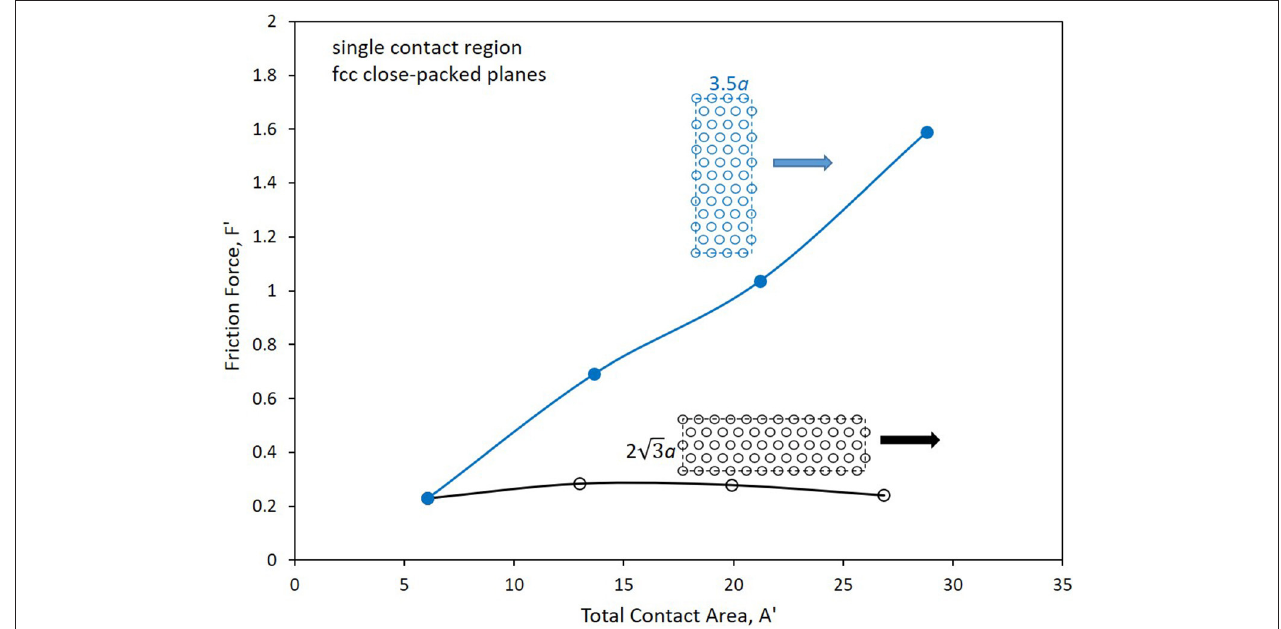
FIGURE 8 | Friction force vs. contact area for long and wide sliders with close-packed slider on (111) plane of fcc slab.